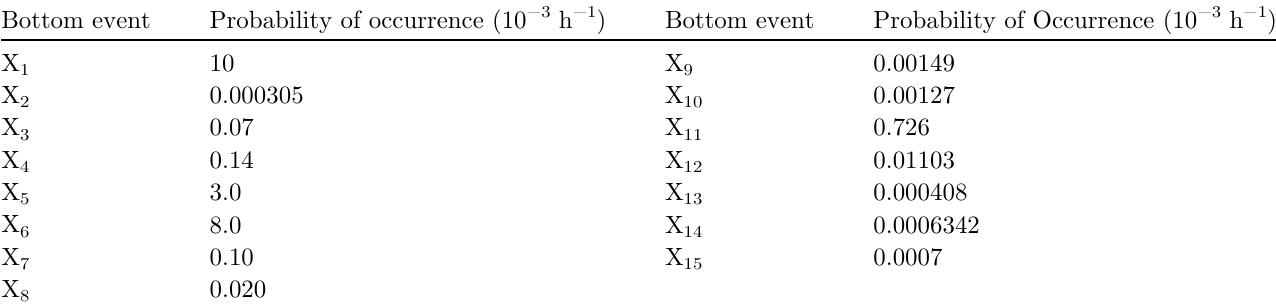
Table 2. Occurrence probability of bottom events. Bottom